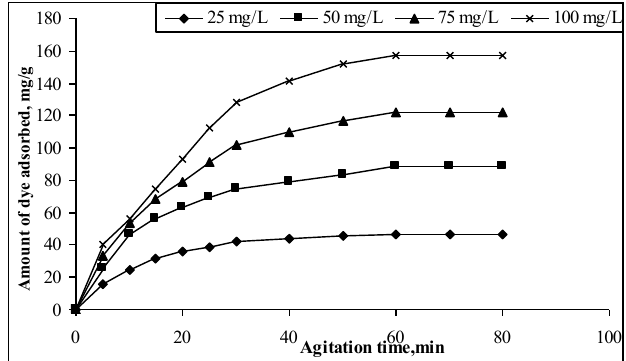
Figure 3. Effect of Initial Dye concentration and contact time for the adsorption of RR onto PPC.